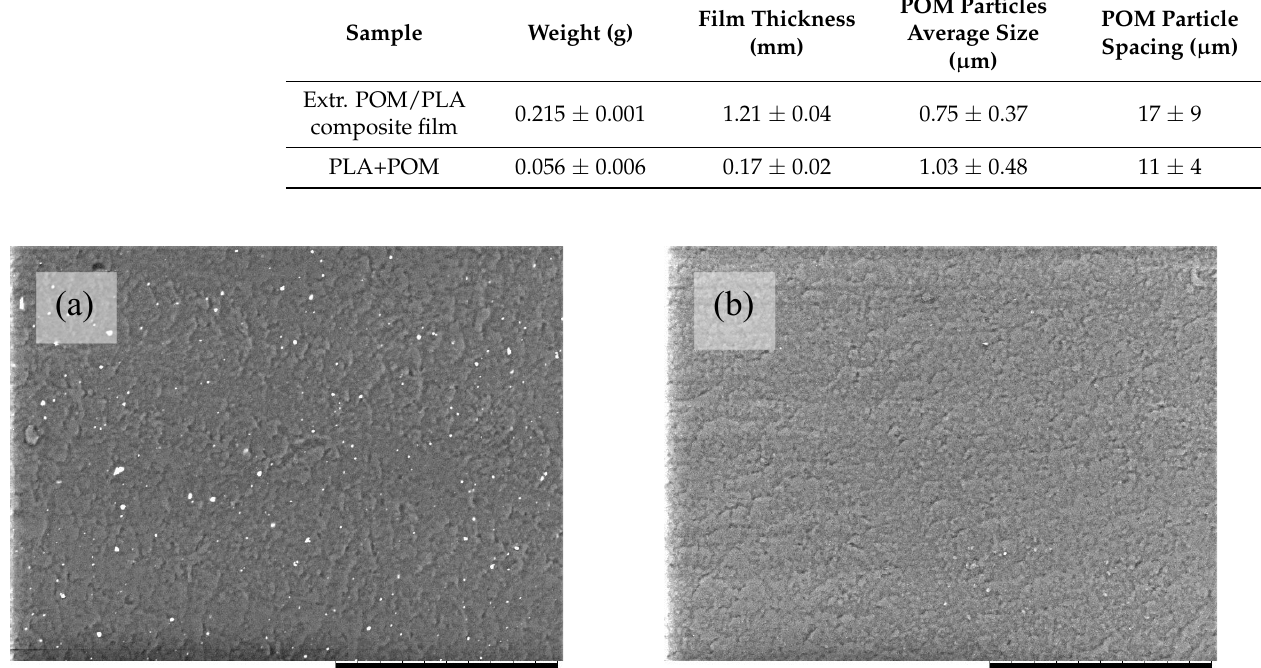
Table 2. The main characteristics of the POM/PLA composite films.